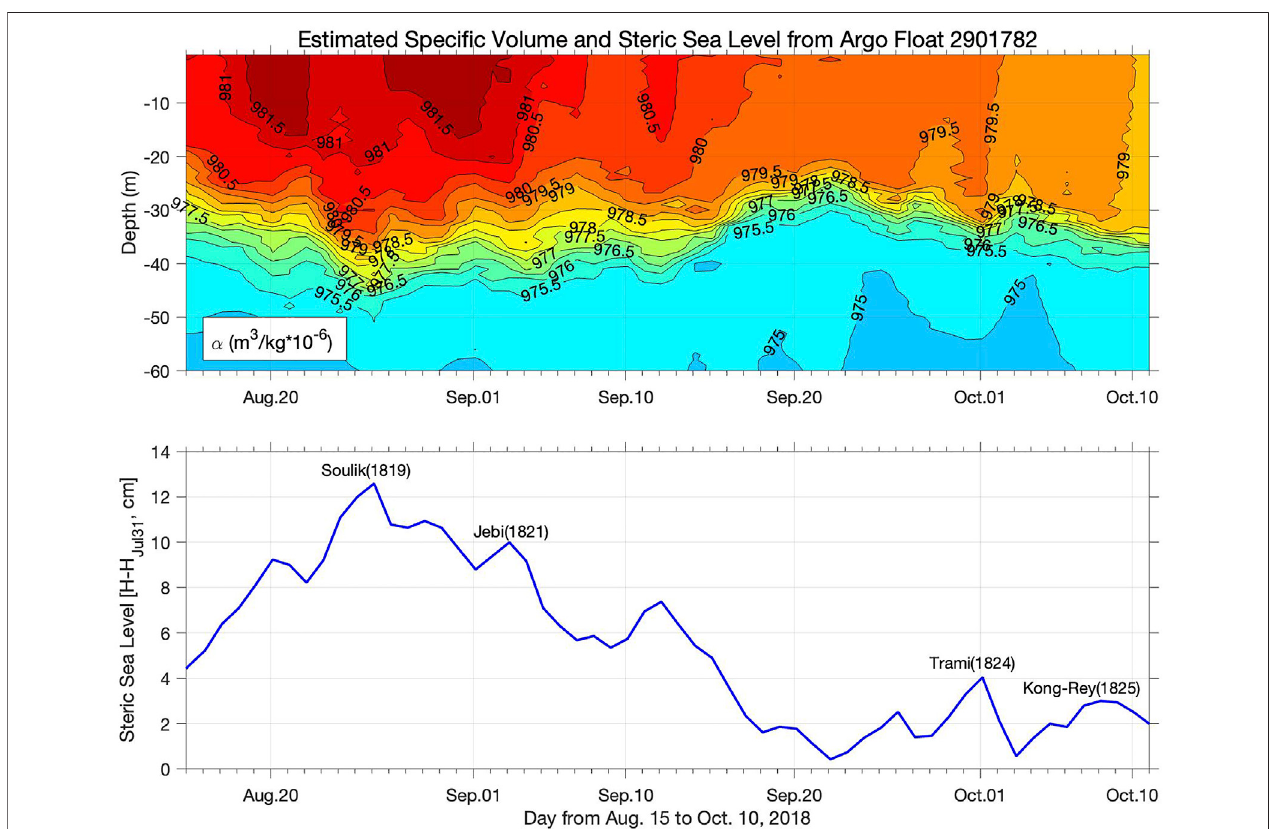
FIGURE6| Calculatedspeci fi cvolumeofsea waterand thesteric sealevelchangefromAugust15toOctober10,2018.Thestericsealevelwascalculatedasthe height relative to the value of 31 July 2018.